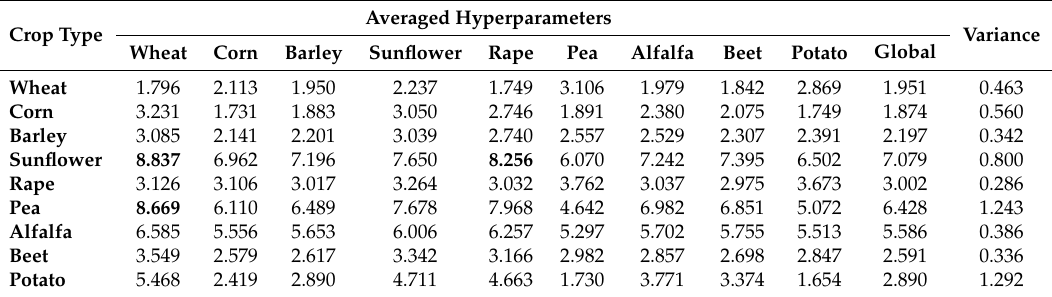
Table 3. Variation in percentage of LAI obtained with precalculated hyperparameters with respect to the benchmark, i.e., LAI values predicted with per-pixel optimization. The last column exhibits the variance in the percentage.